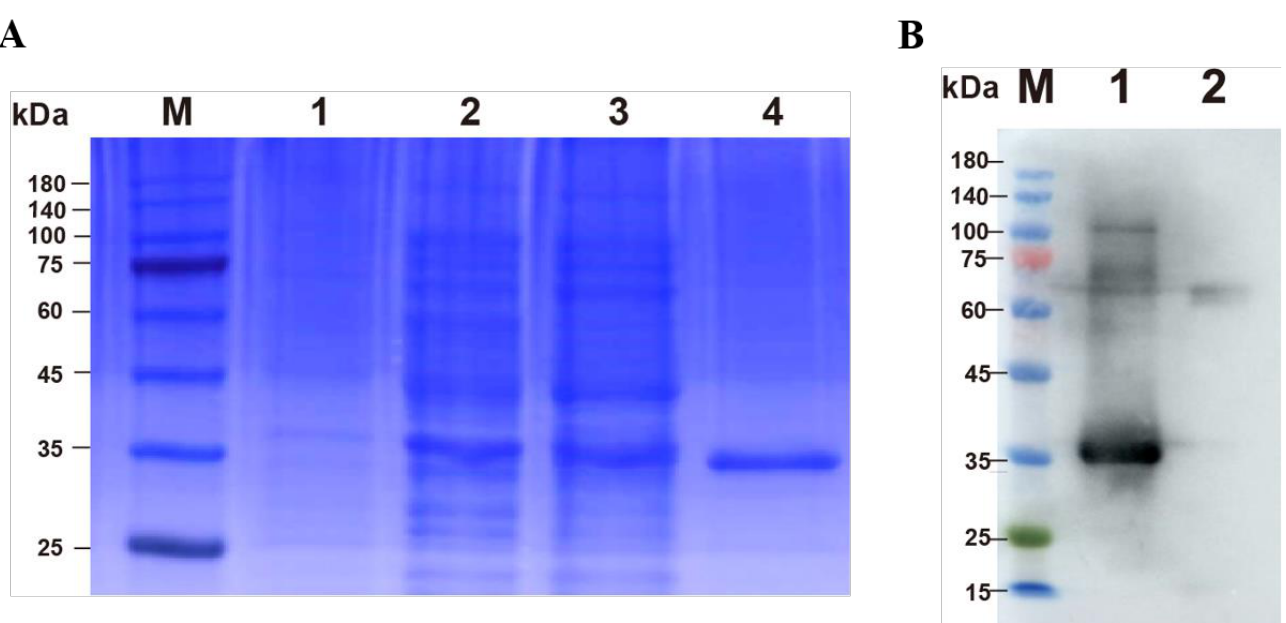
Figure 3. Results of p30 expression and purification. ( A ) Expression and purification of p30 protein.